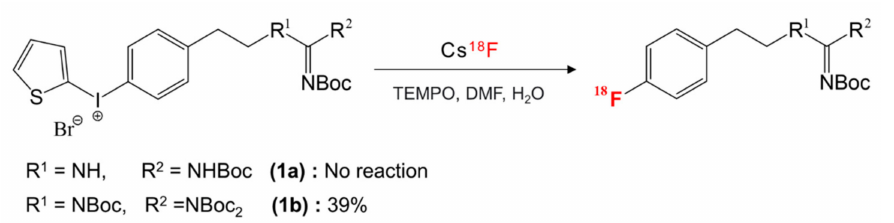
Figure 6: It was proposed by quantum chemical analysis that strong Coulombic interactions among the ionic species and hydrogen bonding between the anion and the amino group –NHR resulted in very di ff erent position of the nucleophile relative to the electropositive C atom. As shown in Figure 6, − the nucleophile F in (pre-8a) forms a hydrogen bond with the amino group in guanidine, and this interaction moves the nucleophile far away from the iodonium site. Thus, the S N Ar reaction may never proceed from this complex. On the other hand, in (pre-8b), the absence of the hydrogen bonding with − the fully protected (N,N’,N¨,N¨-tetrakis-Boc) amine group allows F to be near the iodonium site, and − therefore from this favorable configuration the nuclephilic attack of F onto the electropositive C atom may easily ensue. This example seems to give a good answer to the question posed above: By carefully monitoring the ionic interactions and hydrogen bonding, it is possible to locate the nucleophile at a position that is favorable for S N Ar